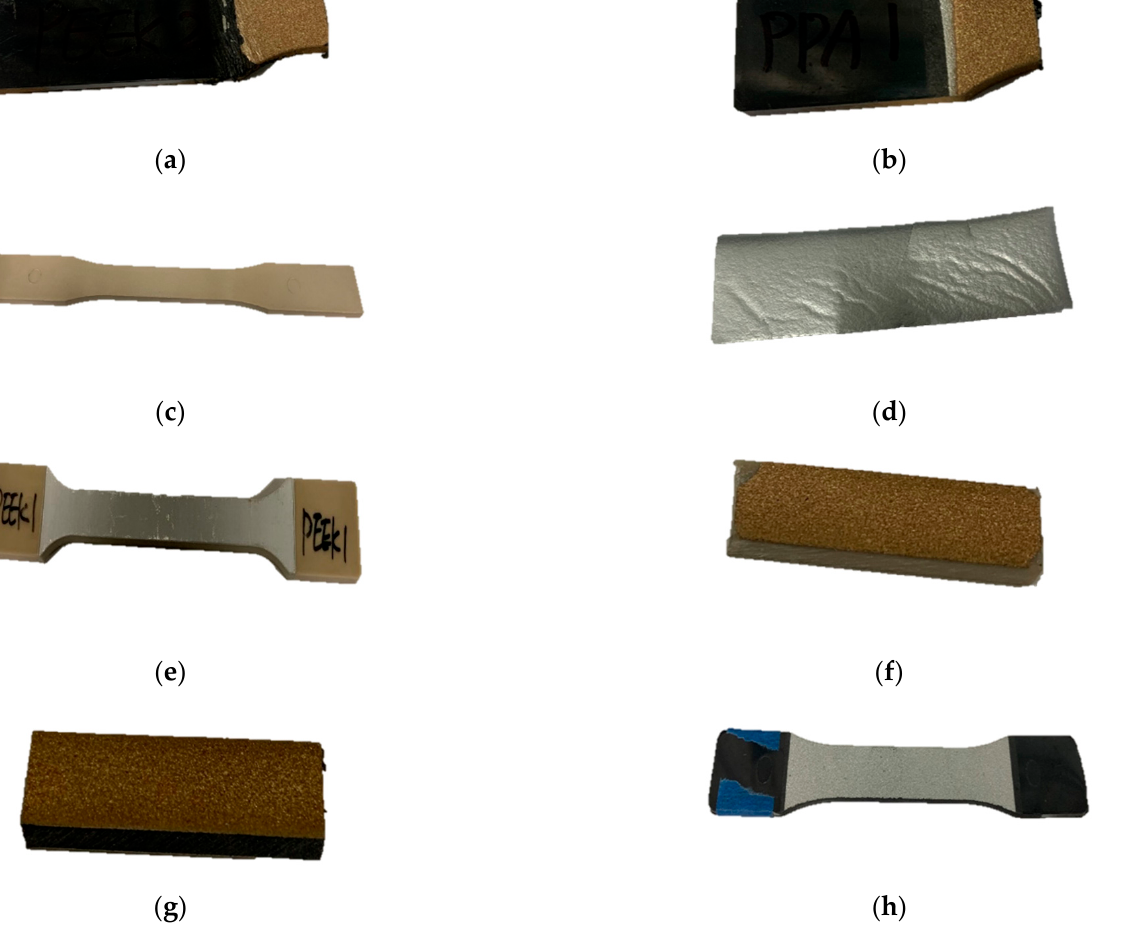
Table 1. The electrical properties of the samples.